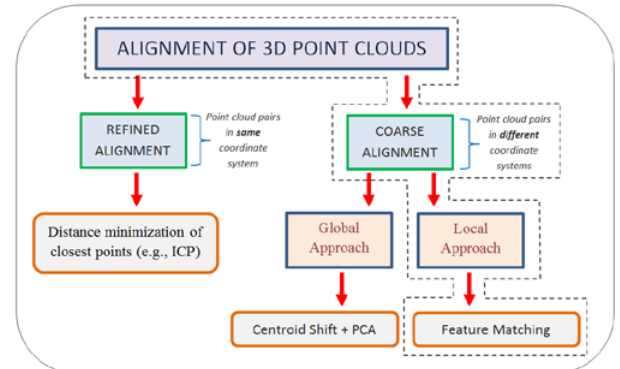
Figure 1. Distinction amongst various 3D point cloud alignment (co-registration) approaches (this work concentrates on the framework marked by the dashed